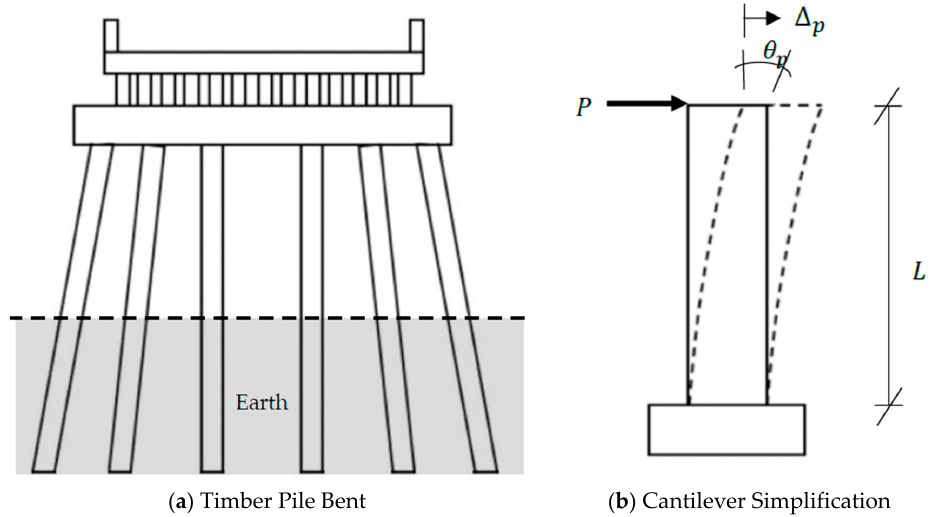
Figure 5. Pseudo-static displacement and pseudo-static rotation of a cantilever